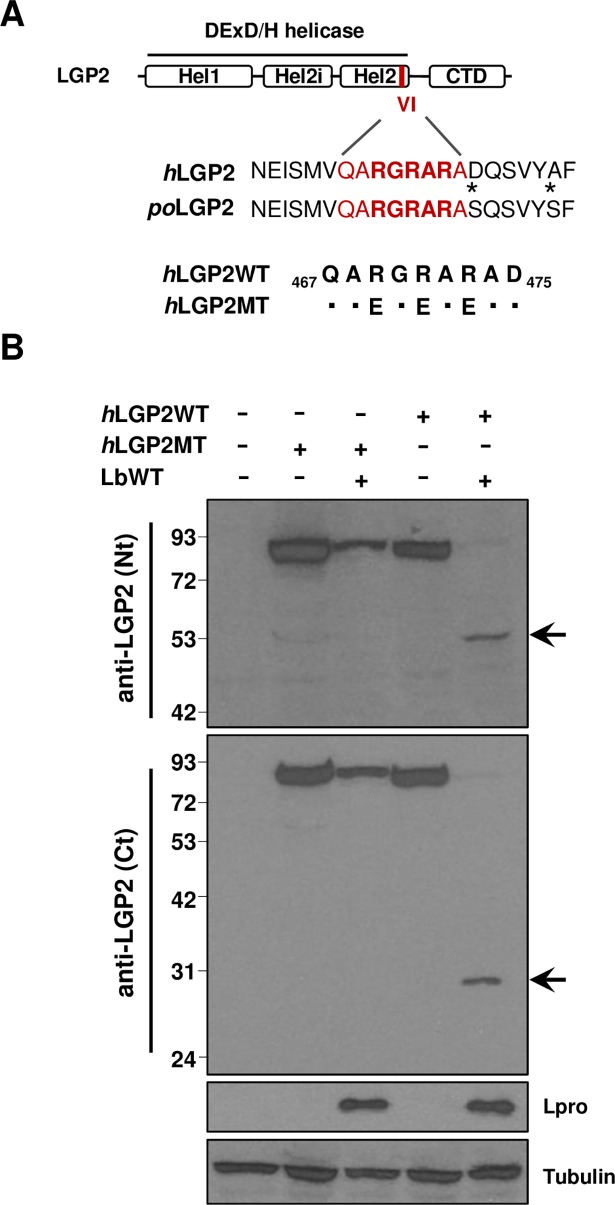
Mutation of the putative target sequence in LGP2 abolishes cleavage by Lbpro.(A) Schematic representation of LGP2 showing the three subdomains in the conserved DExD/H helicase domain (Hel1, Hel2i and Hel2) and the C-terminal domain (CTD). The position and sequence of the conserved helicase motif VI (in red) and surrounding residues in the human and porcine proteins are indicated. Amino acid substitutions in the mutant version of hLGP2 (hLGP2MT) compared with WT sequence are indicated in the corresponding positions. (B) HEK293 cells were transfected with a plasmid encoding hLGP2-Myc-DDK (hLGP2WT) or its mutant version as indicated above (hLGP2MT) either alone or together with a plasmid encoding LbWT. The amount of DNA in all transfections was balanced with EV (-). Cell lysates were analyzed 24 h later by western blot for the indicated proteins using the specified antibodies. The N- and C-terminal cleavage products of LGP2 are indicated with arrows.